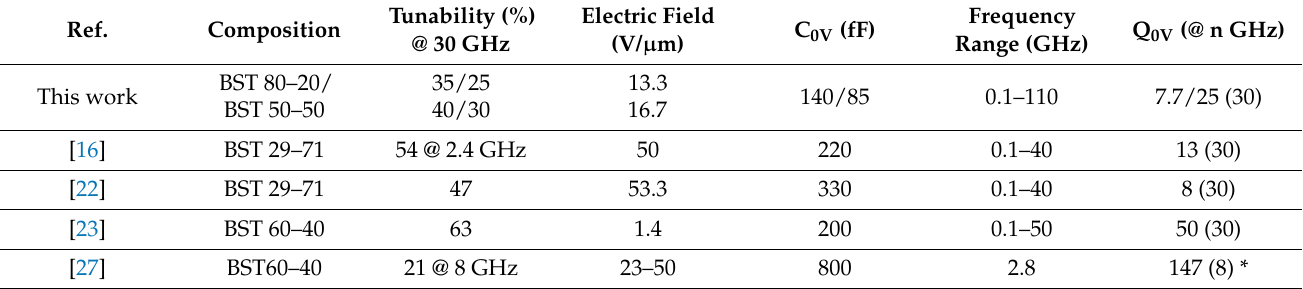
Table 2. Comparison of high-frequency performances for BST thin films integrated in IDC devices.